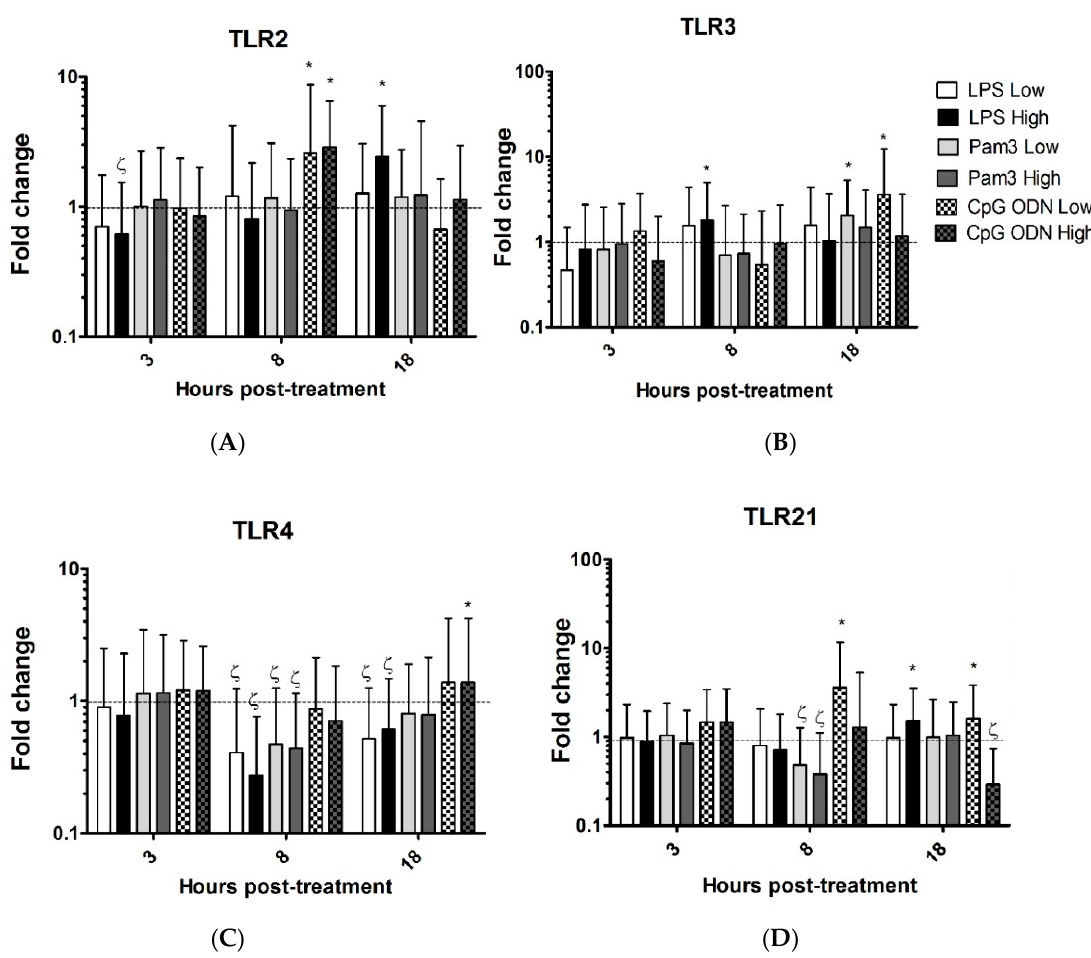
Figure 2. Relative expression of Toll-like receptor (TLR) 2 ( A ), 3 ( B ), 4 ( C ) and 21 ( D ) in the trachea. TOCs were treated with two concentrations of LPS from E. coli O26:B6 (1.0 µ g/mL (LPS low) and 10 µ g/mL (LPS high)), Pam3CSK4 (1.0 µ g/mL (Pam3 low) and 10 µ g/mL (Pam3 high)), CpG ODN 1826 (1.0 µ g/mL (CpG ODN low) and 10 µ g/mL (CpG ODN high)). Control groups received either non CpG ODN (10 µ g/mL) or medium. Gene expression was assessed at 3, 8 and 18 h post-treatment using quantitative RT-PCR, relative to the housekeeping gene β -actin. Gene expression is presented as fold change relative to the medium group in LPS and Pam3CSK4 (low and high doses) groups. Gene expression is presented as fold change relative to the non CpG ODN group in CpG (low and high doses) groups. Error bars represent standard errors of the means. Fold changes and standard errors were calculated using REST software. Significant up-regulation ( p ď 0.05) is indicated by *. Significant down-regulation is indicated by ζ . There were six biological replicates in each